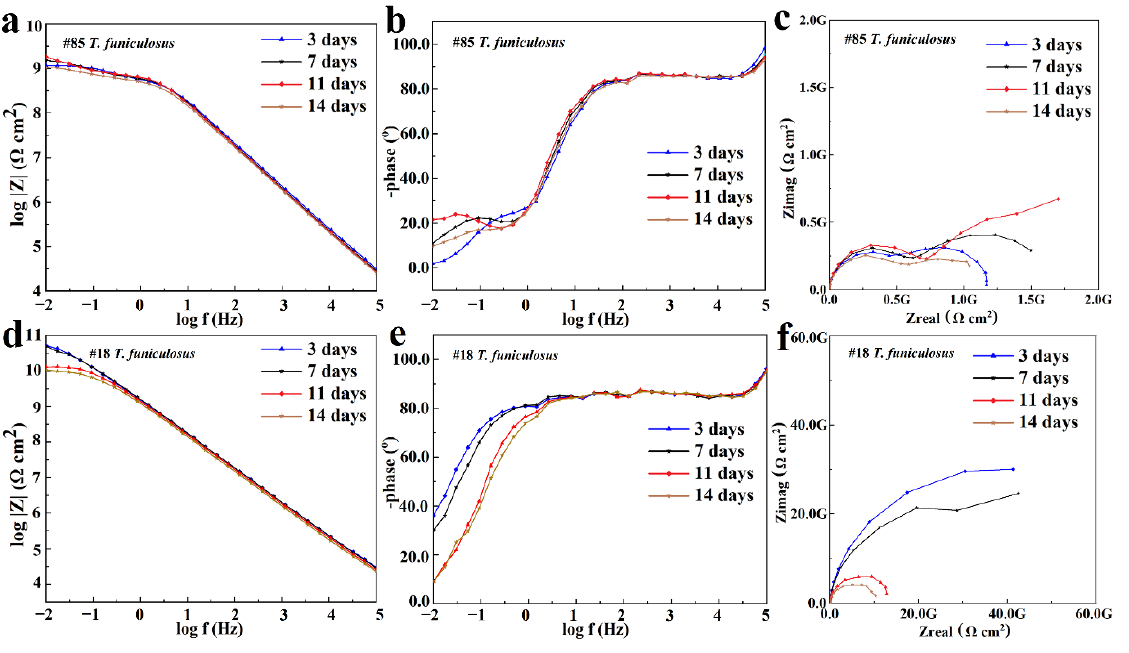
Table 2. EIS fitting results of the #85 electrode immersion in the T. funiculosus -contained medium for different times.